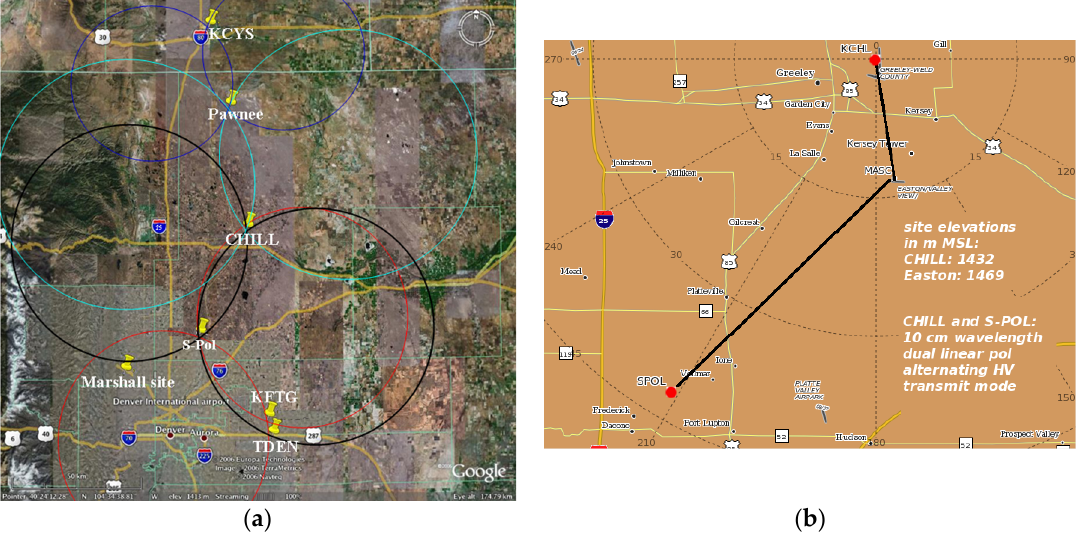
Figure 18. ( a ) The Front Range Observational Network Testbed (FRONT) [49] map showing location of various radars; ( b ) MASCRAD Easton Field Site is located about 12.92 km south/southeast of the CSU-CHILL Radar, along the baseline to the SPOL